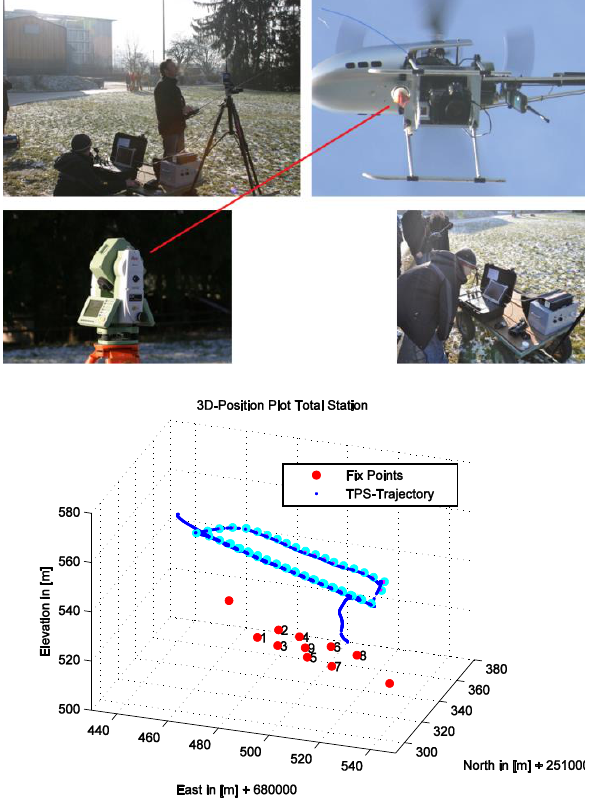
Figure 5, UAV 3D Reference System (Total